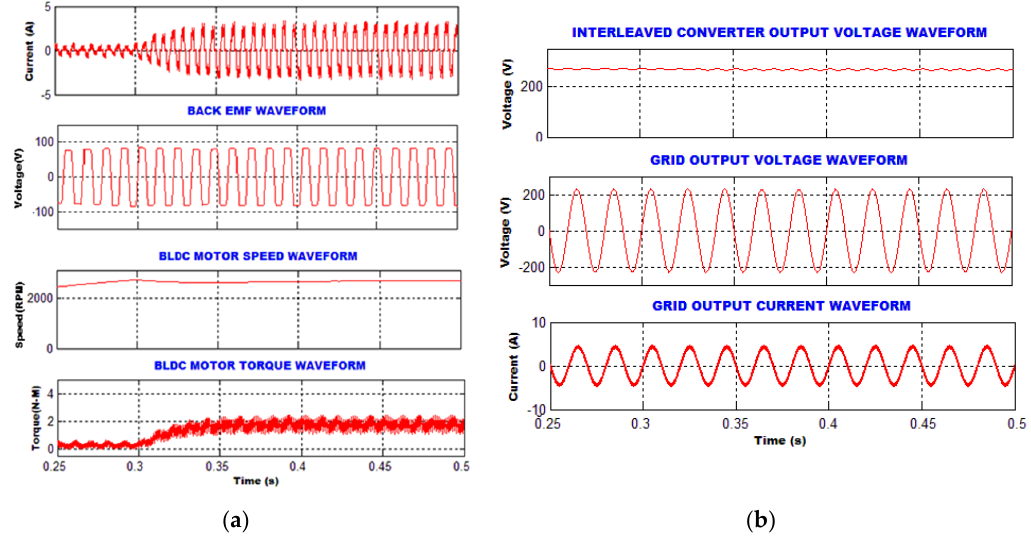
Figure 9. Performance after applying a load of 2 Nm: ( a ) the brushless direct current motor; ( b ) the interleaved Luo converter and grid.